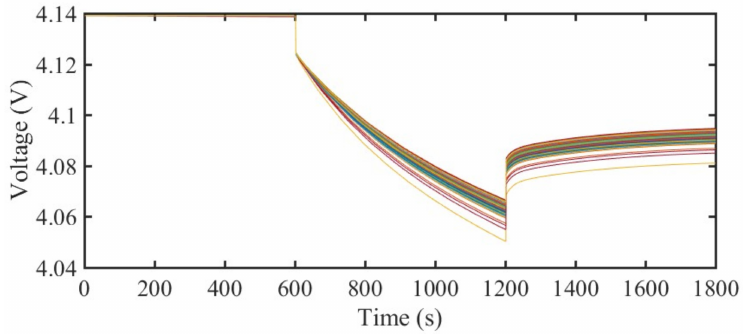
Figure 6. Voltage curves of 108 cells.